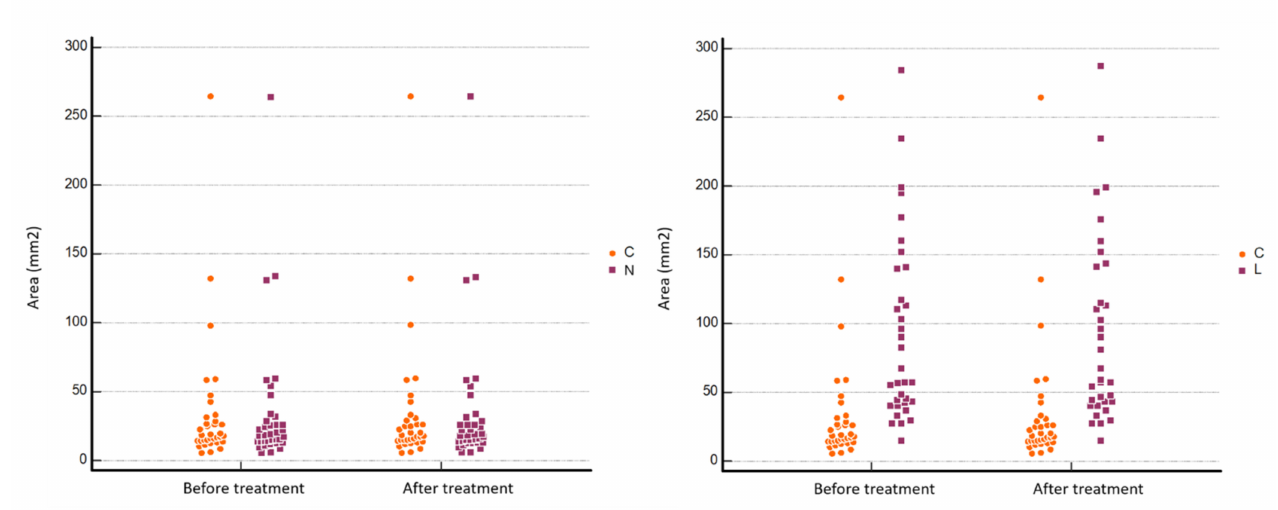
Figure 2. Accuracy of manually traced nidus ROIs (NR) and Lesion ROIs (LR) when compared to Control ROIs (CR) both on pre and post-treatment evaluation. There were no statistically sig- nificant differences in ROIs’ area measured (two-factor ANOVA with repeated measures on one factor, CI = 95%) on pre and post-treatment CT examinations. Y axis: ROIs’ area (C: Control ROI area; L: Lesion ROI area; N: Nidus ROI area).